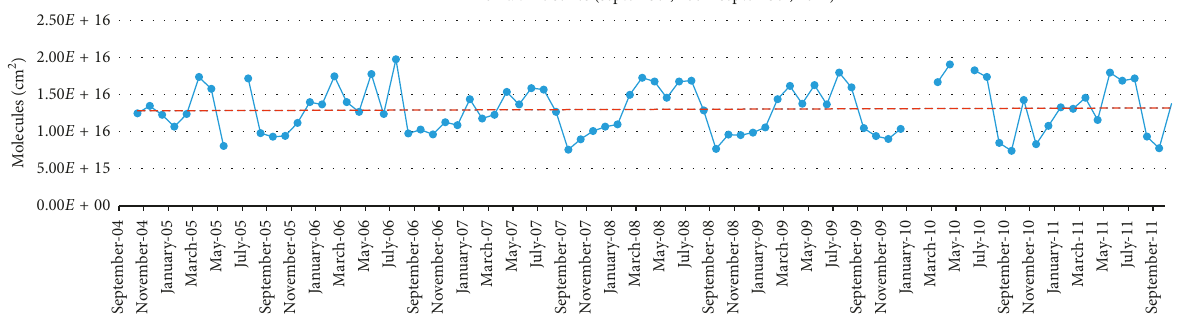
Figure 3: Time series of ammonia columns (molecules/cm 2 ) over South Asia showing high peak over the month of July and a slight rise from 2004 to 2011.